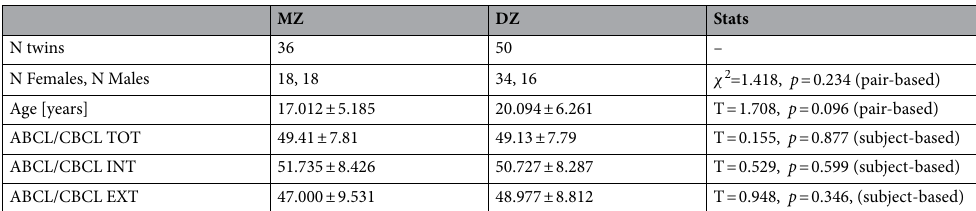
Table 1. Demographic and behavioral information of the sample. For continuous variables, means ± standard deviations are reported. MZ: monozygotic; DZ: dizygotic; T: T-statistics; χ 2 : χ 2 statistics; p: p-value; ABCL/ CBCL: Adult/Child Behaviour CheckList; TOT: total score; INT: internalization score; EXT: externalization